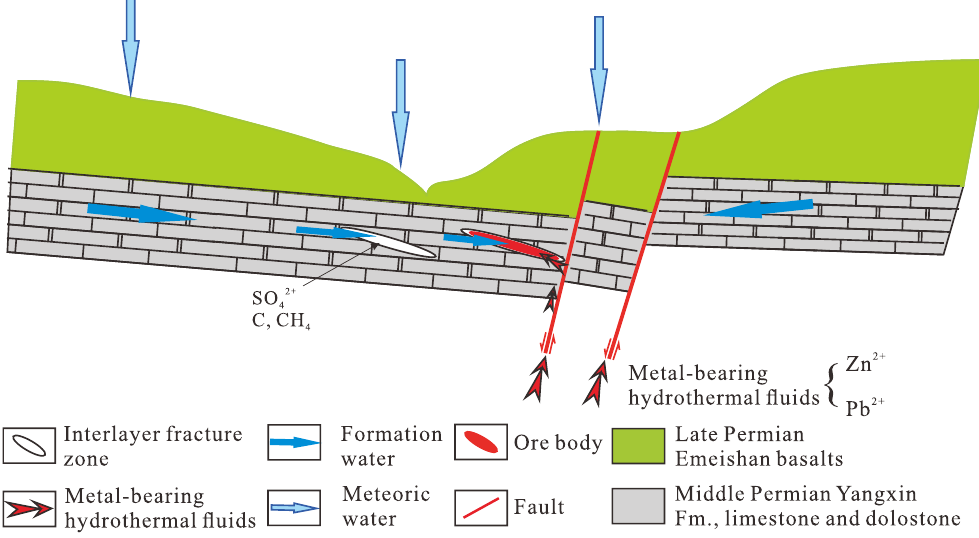
Figure 12. A sketch of the metallogenic model favoured for the Fuli Pb-Zn deposit. Therefore, we suggest that the Fuli Pb-Zn deposit might have formed due to the mixing of metal-rich, oxidized acidic fluid with sulfur-rich, reduced alkaline fluid.